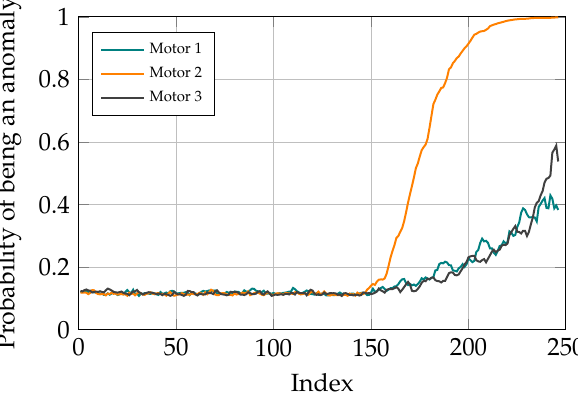
Figure 14. Simulation results with distortion added to motor